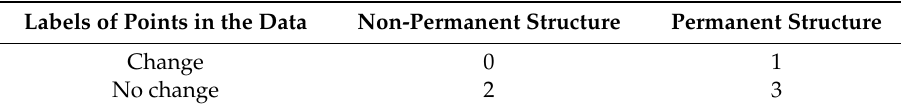
building structure. The points with label 1 are interesting for change detection of the 3D